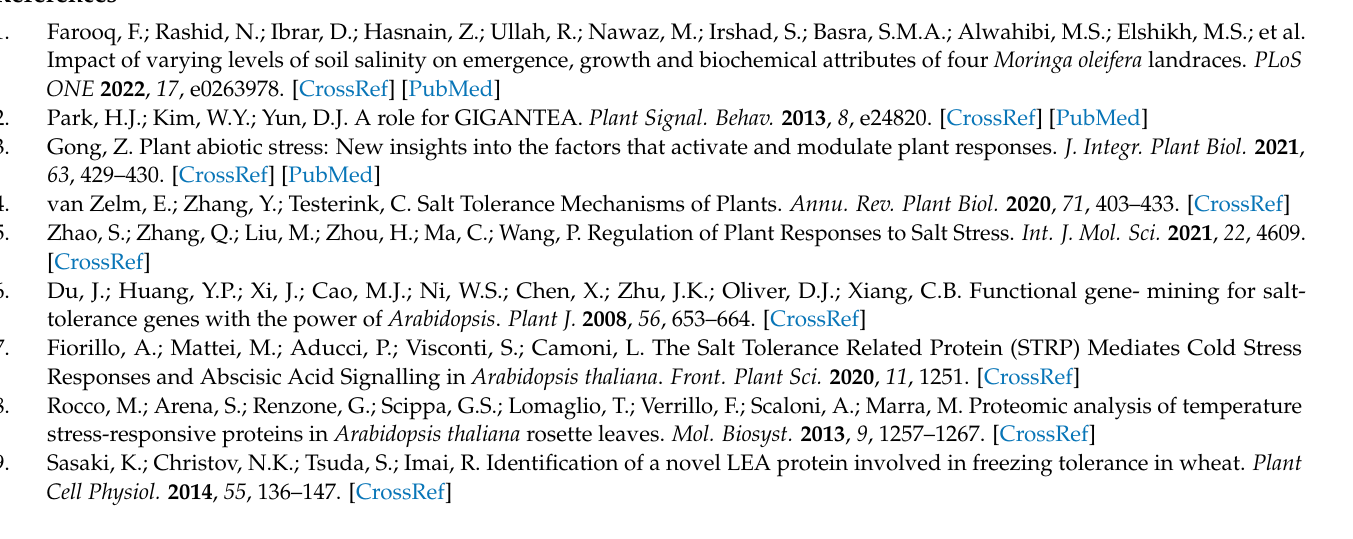
Figure S2: Representative confocal images of root and leaf tissues showing STRP–YFP overexpression. Representative root and leaf sections of STRP OE plants were imaged for GFP fluorescence by confocal microscopy with a laser scanning microscope (Olympus FV1000). Laser 488 nm (Argon) was used to detect the green fluorescence of YFP using a 20x objective. Figure S3: Full–length blot of STRP levels, with NaCl ranging from 50 mM to 150 mM, reported in the manuscript in Figure 1A. Figure S4: Full– length blot of the time–course experiment of STRP levels under 150 mM NaCl treatment, reported in the manuscript in Figure 1B. Figure S5: Full–length blot of MG132 experiment, reported in the manuscript in Figure 1D. Figure S6: Full–length blots of STRP OE plants immunodecorated with anti-YFP and anti-STRP antibodies, are reported in the manuscript in Figure 2B. Figure S7: